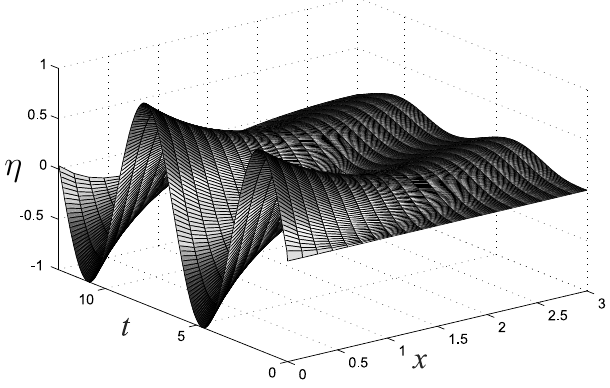
Fig. 2. A periodic tidal wave in a porous medium as the result of Eq. (21) with a significant wave reduction.